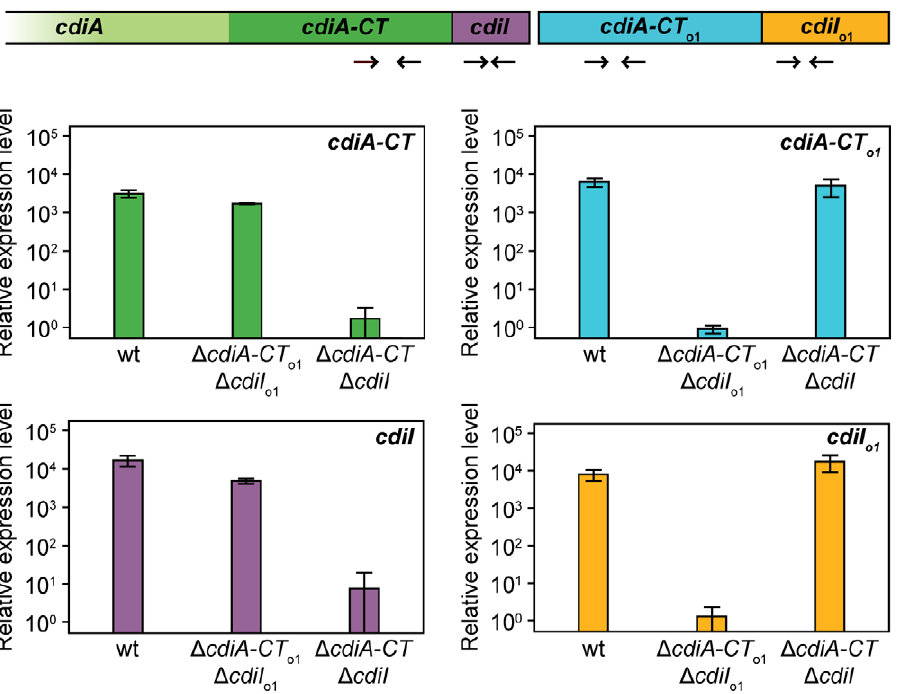
Figure 7. The EC93 orphan region is transcribed. RNA from E. coli EC93, EC93 D cdiA-CT EC93 D cdiI EC93 , and EC93 D cdiA-CT o1EC93 D cdiI o1EC93 was subjected to quantitative RT-PCR. The primer binding sites within the cdi locus are depicted schematically as arrows. The relative expression levels represent the mean 6 SEM for three independently isolated RNA samples.